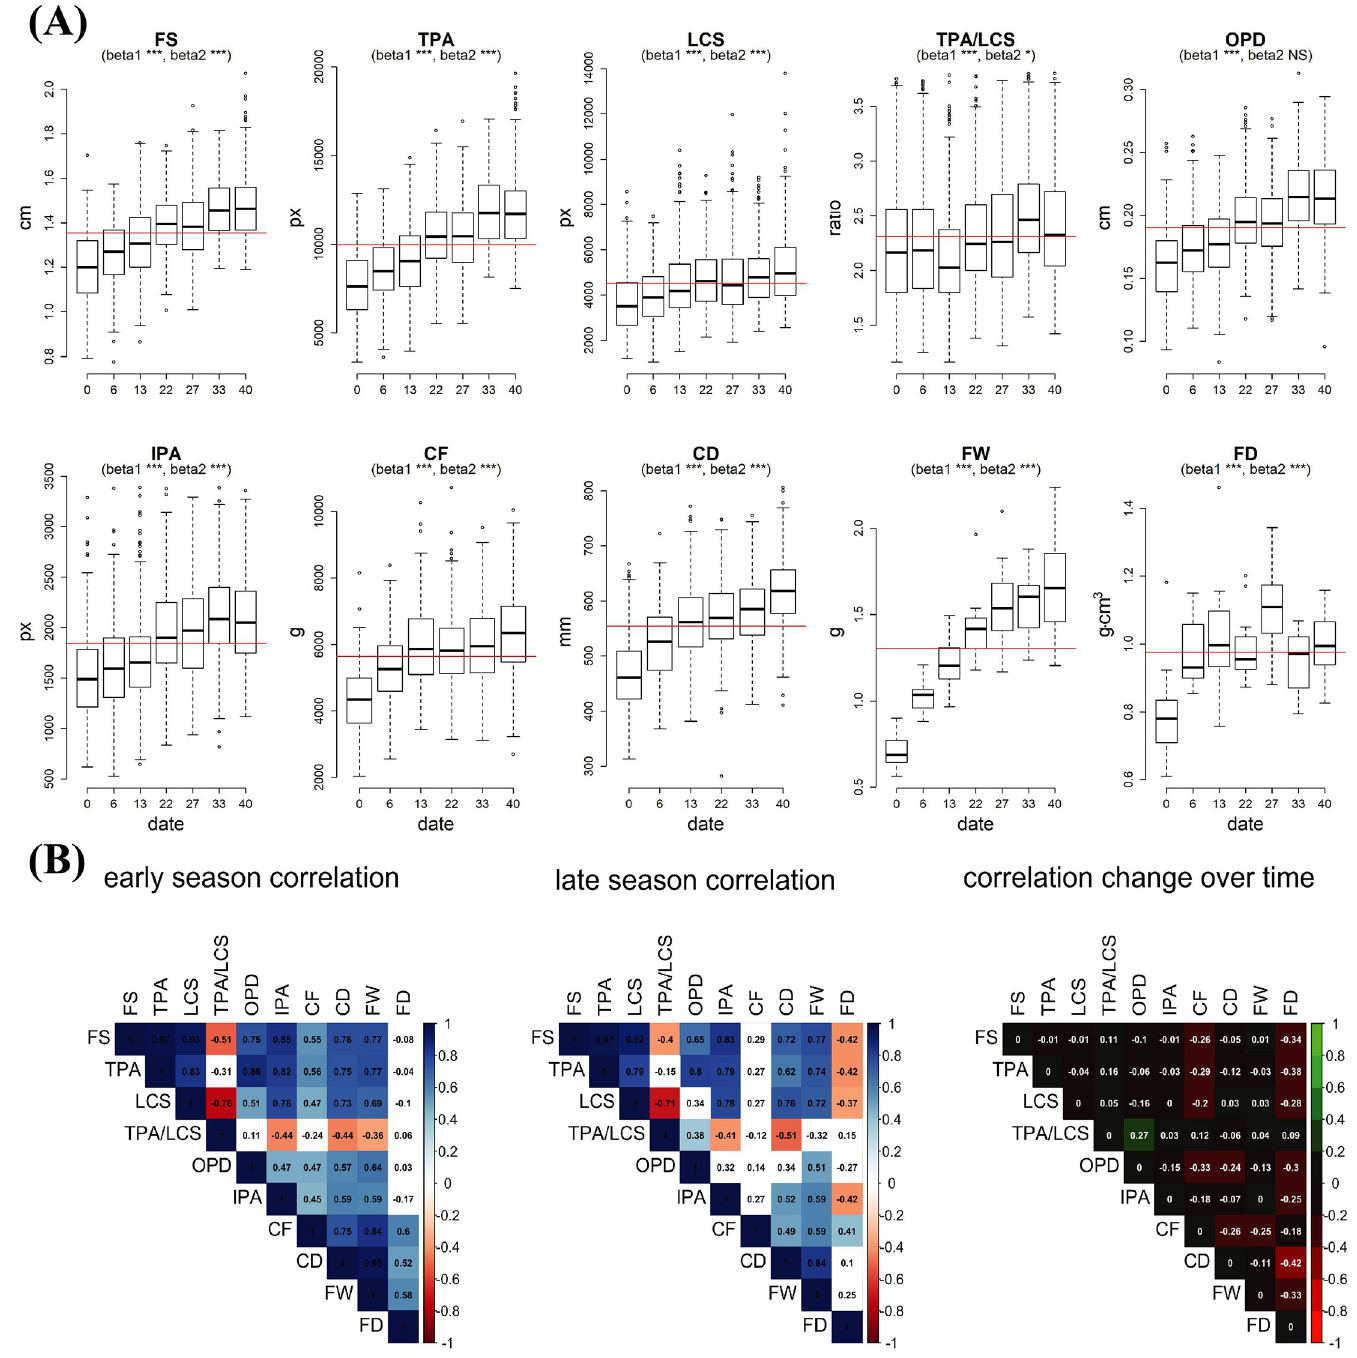
Fig 2. Variation in fruit internal structure and firmness. (A) Changes in fruit size (FS), total pericarp area (TPA), locular cavity size (LCS), total pericarp area-to- locular cavity size (TPA/LCS), outer pericarp diameter (OPD), internal pericarp area (IPA), compression force (CF), compression distance (CD), fruit weight (FW), and fruit density (FD), during the ripening process of cranberry. Quadratic models were used for each phenotype all cultivars as repetitions. On each boxplot, red line indicates the mean across all time points; significance ( ��� = p < 0.005, �� = p < 0.01, � = p < 0.05, NS = p > 0.05) of beta1 ( x ) and beta2 ( x 2 ) terms are provided in the boxplot subtitle. (B) Pearson’s correlation between fruit structure and firmness attributes at dates 0 and 6 (early season, first panel), and 33 and 40 (late season, second panel). Non-significant correlations (at p = 0.05) are colored white. Third panel shows the changes in correlation when comparing late season and early season